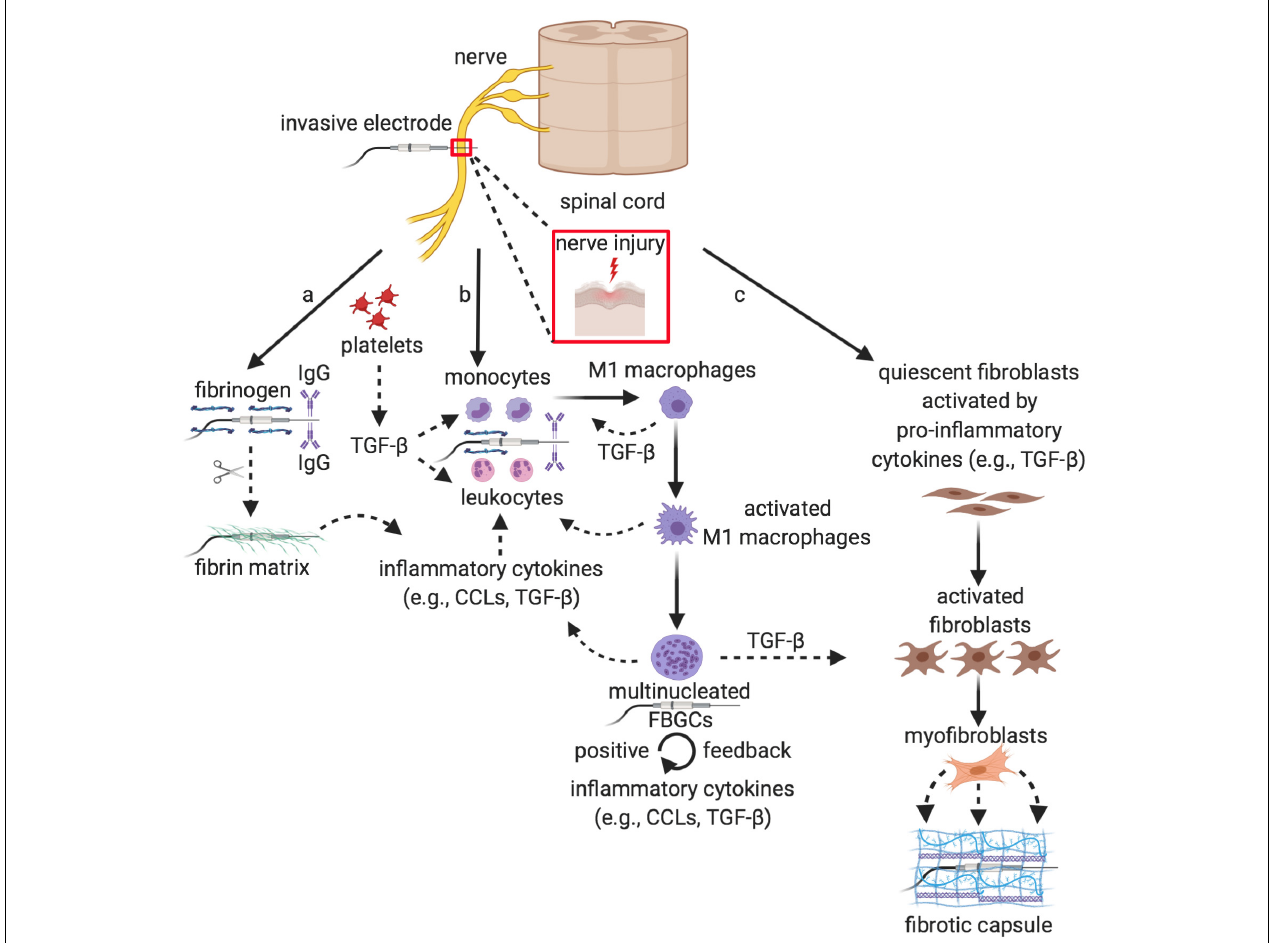
FIGURE 1 | Onset, progression and resolution of the Foreign Body Reaction. Sequence of cellular events of the non-specific immune response elicited by the biomaterial surrounding the invasive electrode implanted into the nervous tissue, which is perceived as a nerve injury: (a) onset, similarly to the wound healing, the adsorption of blood and plasma proteins [in particular, fibrinogen and antibodies (IgG), which will be recognized by the white blood cells of the immune system, and the complement system providing specific binding sites and chemoattractants for circulating leukocytes and monocytes] to the surface of the implant leads to the second step of the process, (b) the progression of the FBR, during which leukocyte and monocyte extravasation that is due to the influence of various chemokines, such as TGF- β , promotes their attraction and adhesion to the electrode surface. Recruited monocytes differentiate into activated M1 macrophages that fuse together into multinucleated FBGCs, which carry out multiple functions including: the increase of the inflammatory response both through a positive feedback mechanism (mainly via additional TGF- β production) and through the recruitment of further monocytes and macrophages, the digestion of the electrode surface while promoting the recruitment of the fibroblasts and their activation to myofibroblasts in the last step of the process, (c) the resolution of the FBR, during which the myofibroblasts secrete the different ECM components around the implant that are responsible for the formation of the fibrotic capsule, which ultimately isolates the electrode from the surrounding tissue. IgG, immunoglobulin G; CCLs, CC chemokines; TGF- β , transforming growth factor β ; FBGCs, foreign body giant cells. Created with